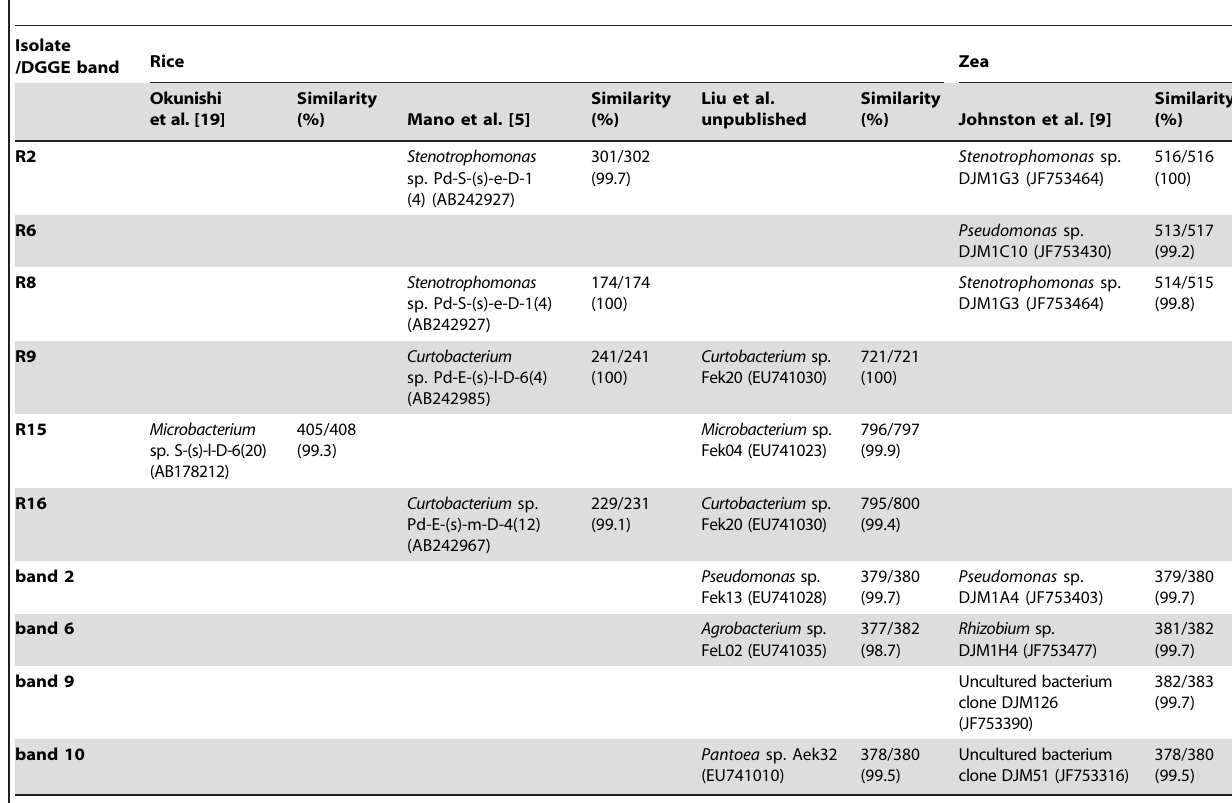
Table 3. Closest match of sequences obtained in this study against public available rice and Zea seed endophyte sequences.